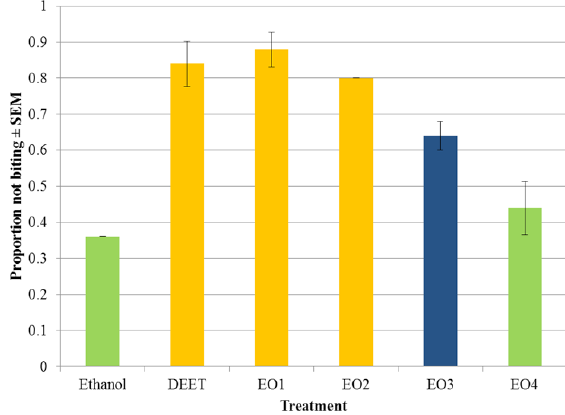
Figure 5: Proportion not biting values of P. heyniae essential oil samples at 10 μg/cm 2 against female Ae. aegypti . DEET at 25 nmol/cm 2 , was used as positive control. Ethanol was used as solvent